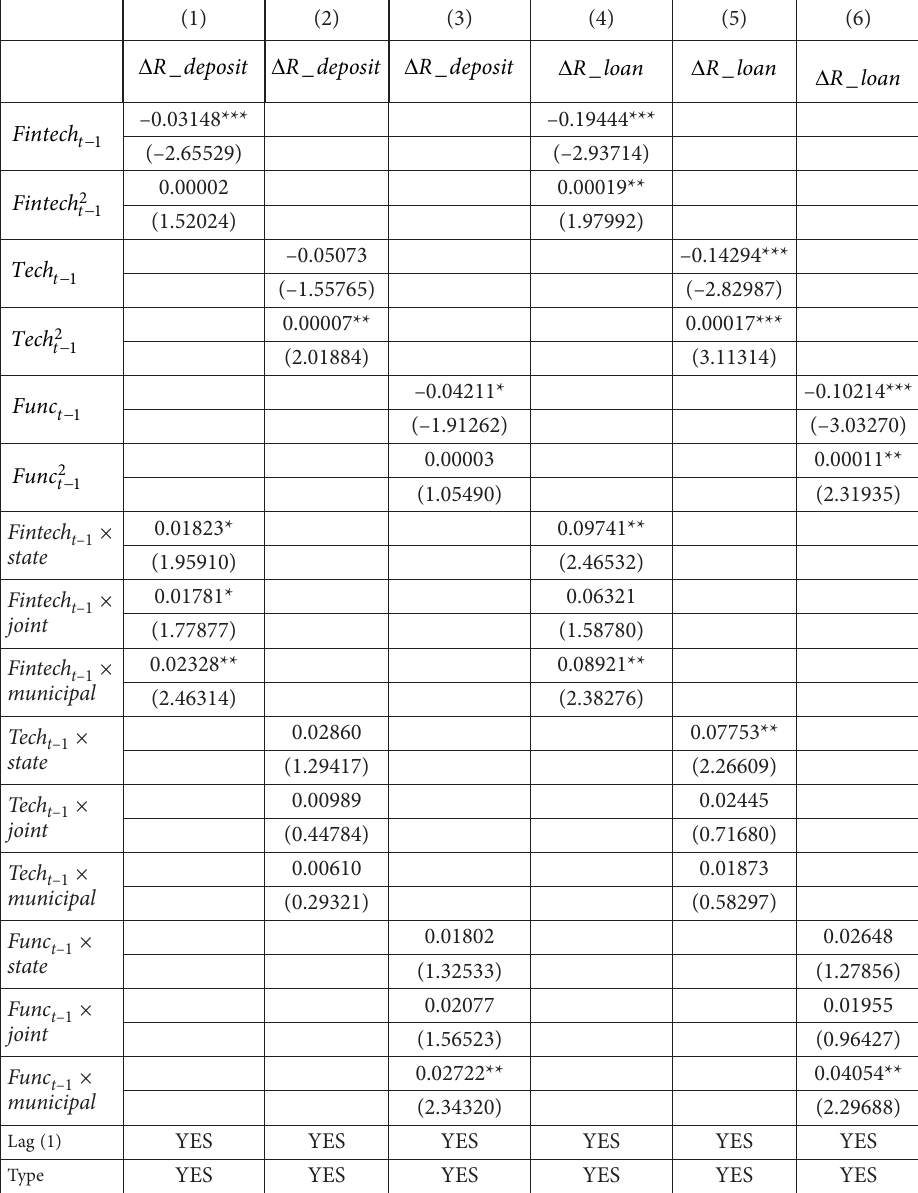
Table 5. Business heterogeneity of the effects of FinTech on market